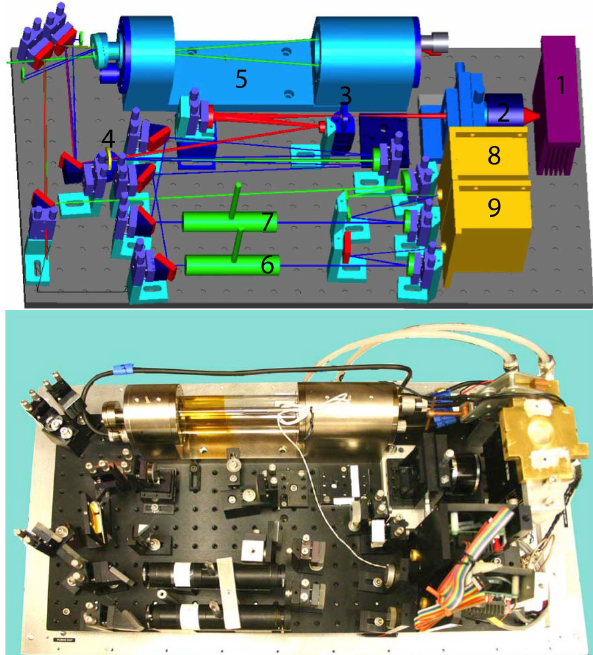
Fig. 4. ABC-prototype instrument optical layout. (a) design: 1 – DFB diode laser; 2 – 15 × reflective objective; 3 – pin hole; 4 – beam splitter; 5 – sample cell; 6 – primary quartz reference cell; 7 – secondary quartz reference cell; 8 – sample detector; 9 – reference detector. (b) photograph of the optical